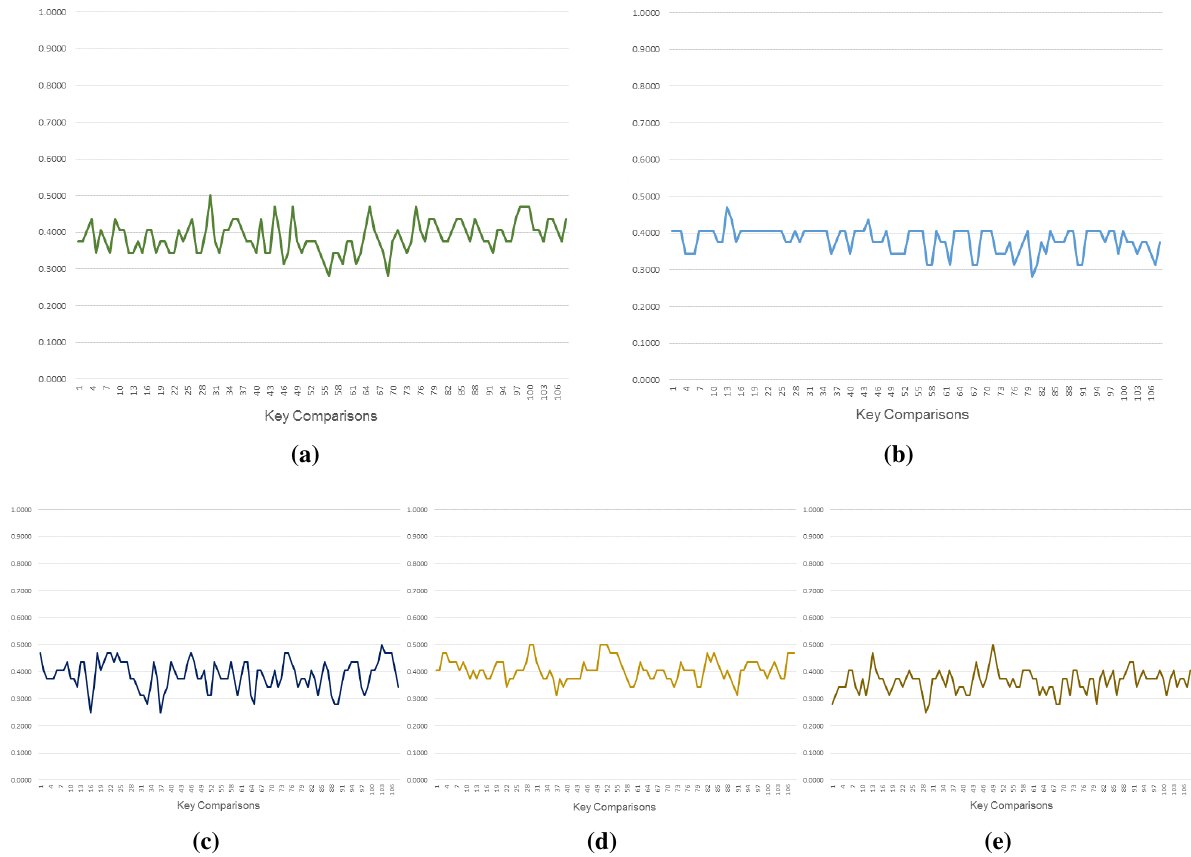
Figure 4. Variation in SSI coefficients. ( a ) Butterfly ( K proposal; ( d ) Zhu et al. ’s proposal; ( e ) Dong et al. ’s